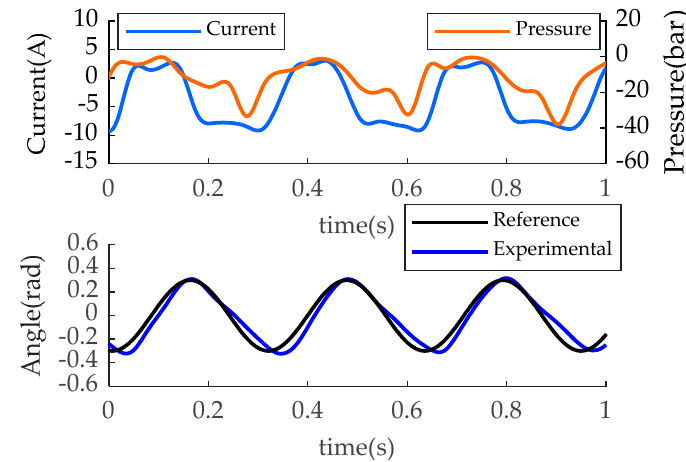
Figure 8. Sensor data of the loading test.